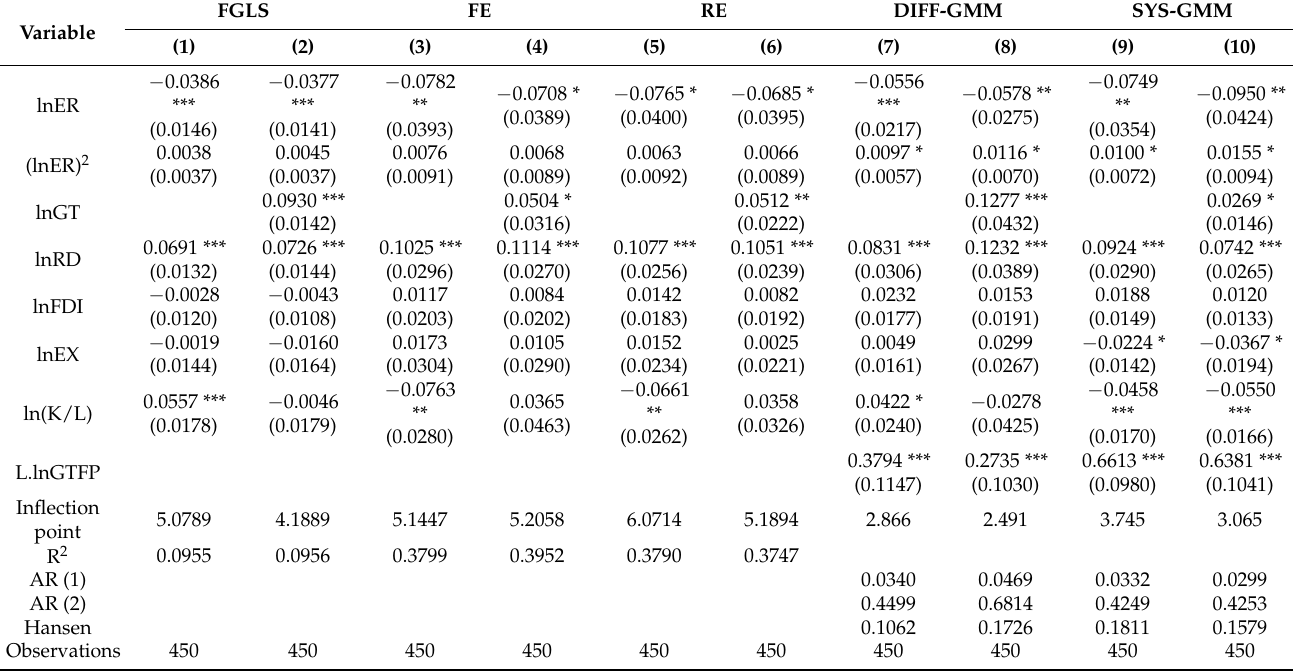
Table 3. The regression results of impact of environmental regulation on GTFP for full